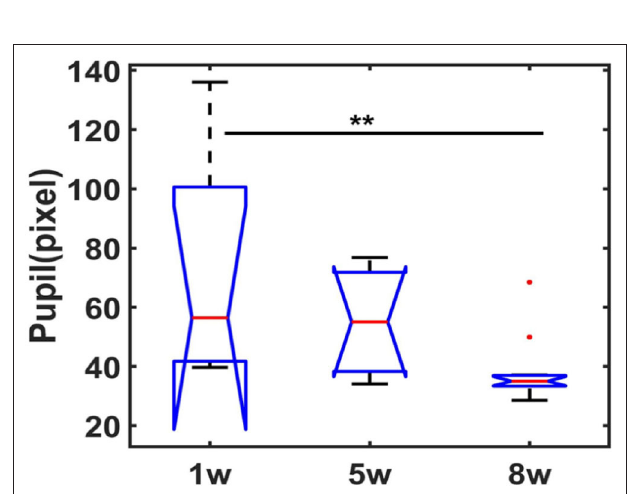
FIGURE 3 | Statistical analysis of pupil dynamics in resting-state following different weeks of training. Boxplot graph represents the pupil diameter changes (central red line is the median, 1w: 56.42, 5w: 55.08s, 8w: 35.04; interquartile range 25th and 75th percentiles denote the maximum and minimum, outliers are shown by red dots, ** p < 0.01, by Bonferroni post-hoc test, mean trials = 9 each week session, n = 3 animals).